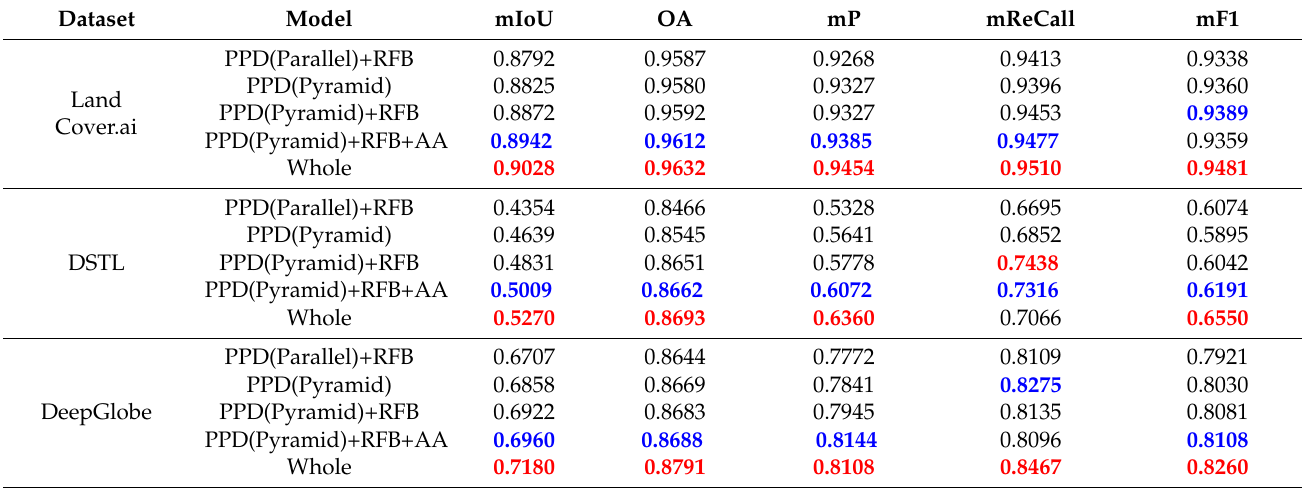
Table 5. The quantitative results of the ablation experiments of architecture on the three datasets. (The red color and blue color indicate the best and the second-best performance). Dataset